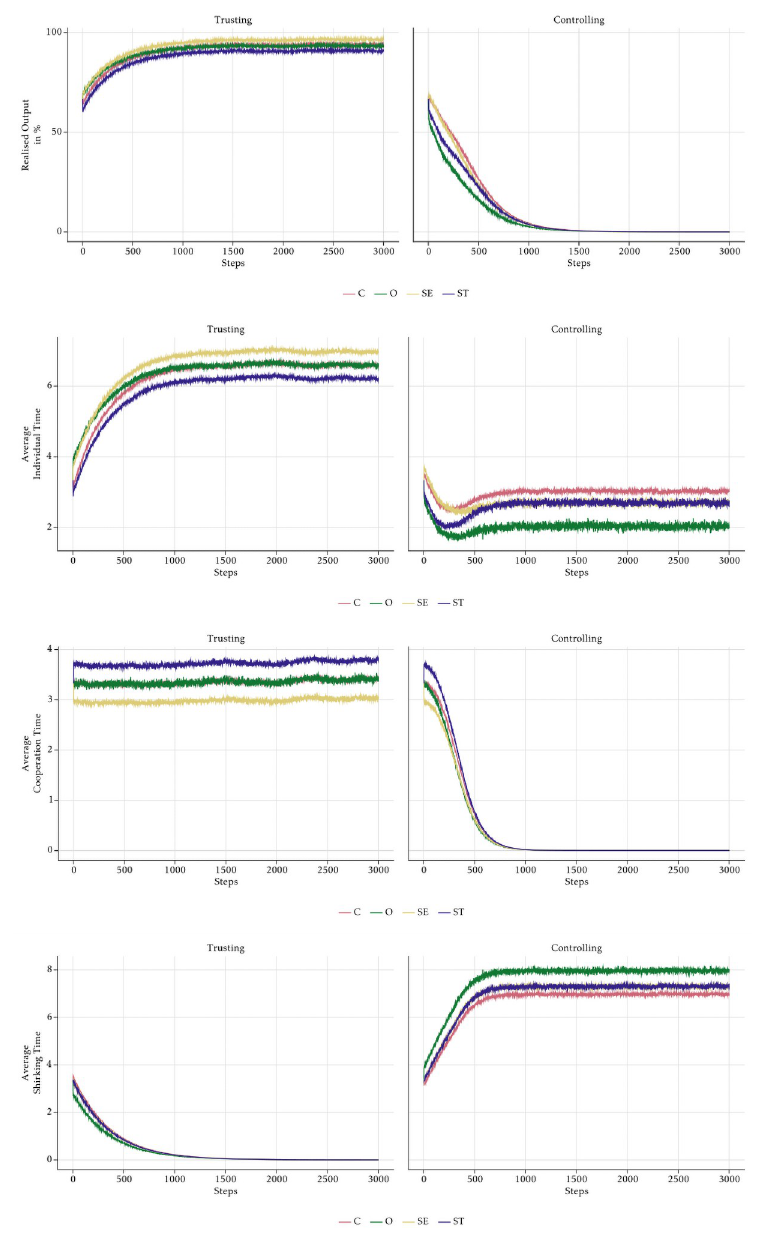
Fig 13. Realised output, average individual, cooperation and shirking time per value-types—No incentives.